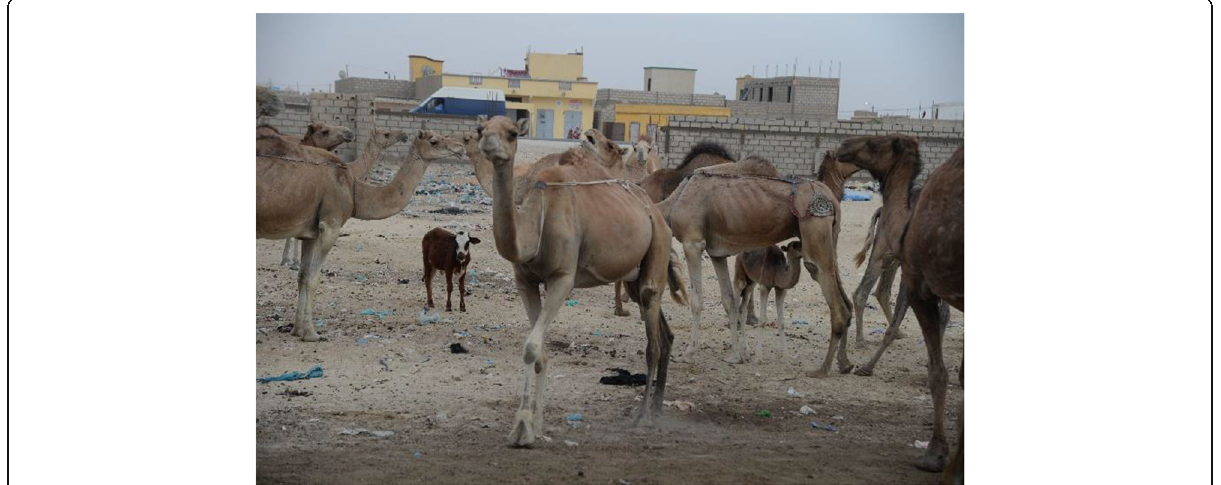
Fig. 4 Dairy camel farm in peri-urban area of Nouakchott, Mauritania (Ph. B.